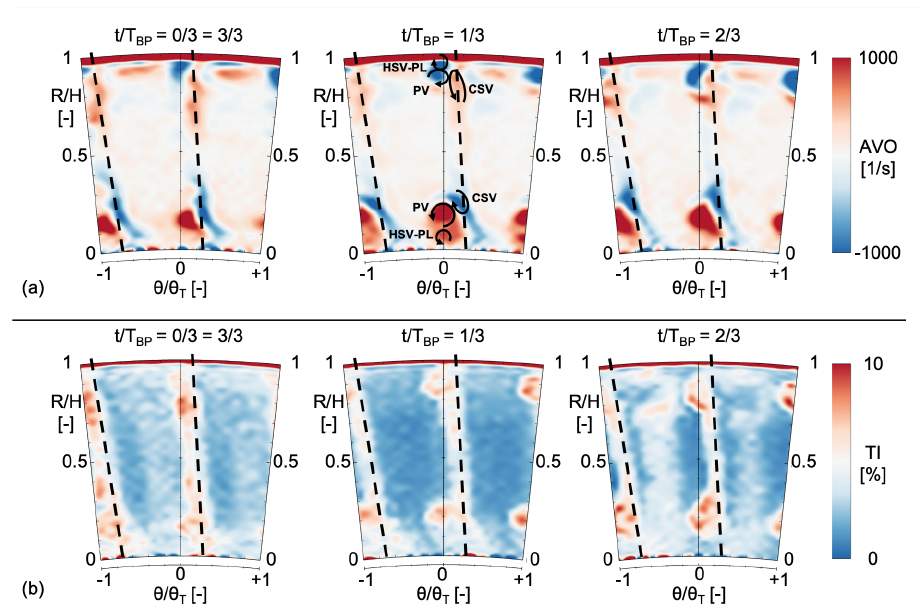
Figure 32. Temporal flow field evolution in the T106 RUB exit flow field ( ∆ x = 0.16 C) at 3 equidistant time steps, Sr = 1.33, φ = 0.97. Axial vorticity (AVO) ( a ) and turbulence intensity (TI) ( b ).